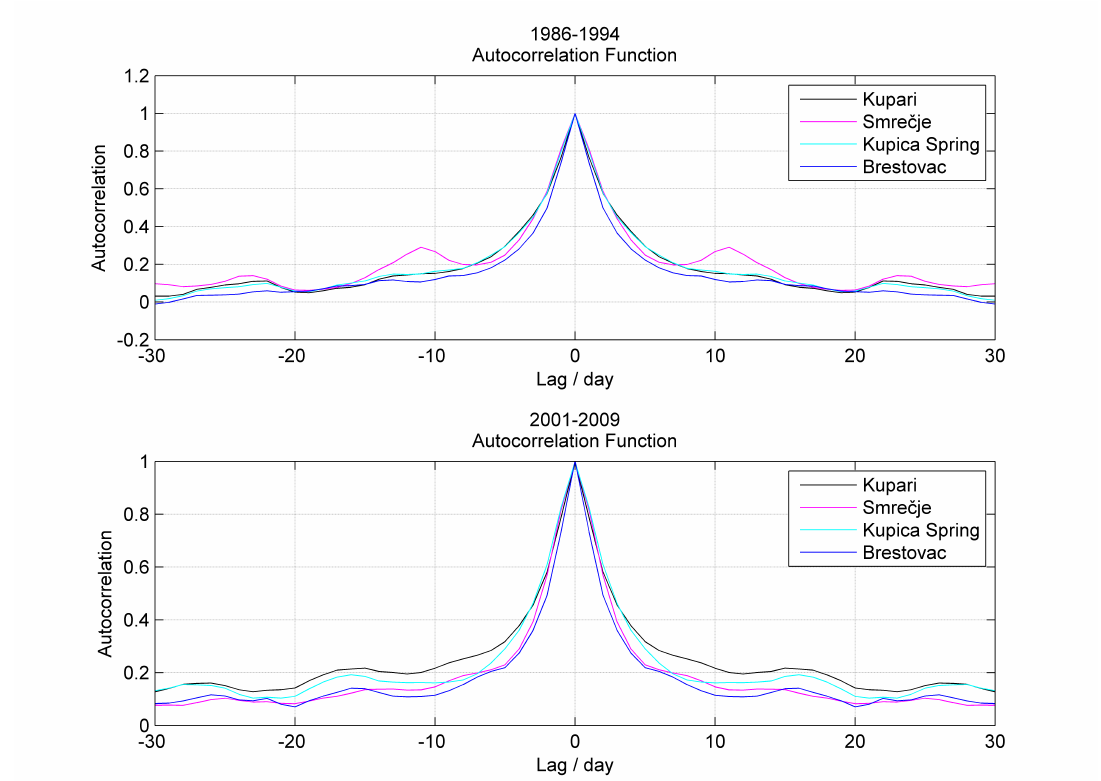
Figure 4. The autocorrelation function obtained for studied hydrological stations for the two analyzed periods.